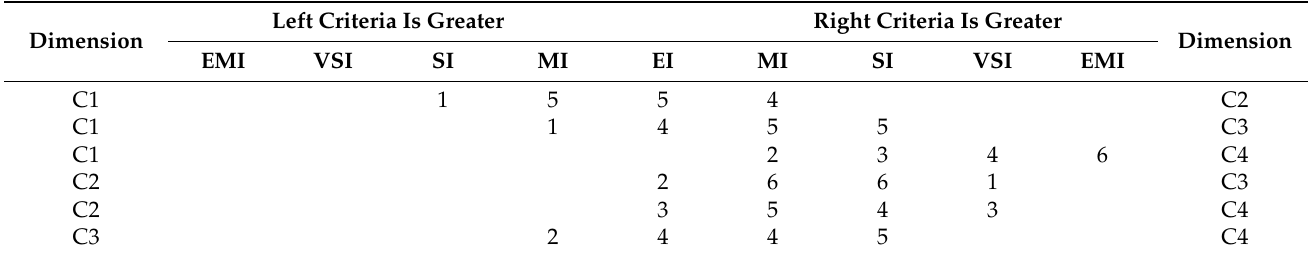
Table 5. The initial comparison matrix of G-AHP.